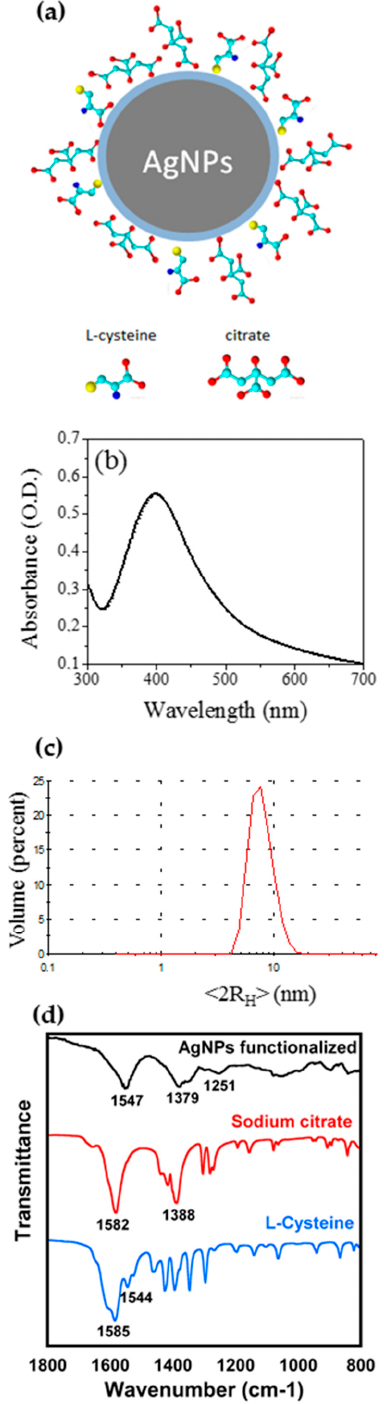
Figure 1. ( a ) Scheme of bifunctionalized hydrophilic silver nanoparticles (AgNPs); ( b ) UV-Vis spectrum in water of AgNPs, with local surface plasmon resonance (LSPR) band centred at 400 nm; ( c ) DLS measurements in water: < 2RH > = 8 ± 1 nm; ( d ) ATR-FTIR spectra of bifunctionalized AgNPs (Top) and the capping agents, Cit (Center), and L-cys